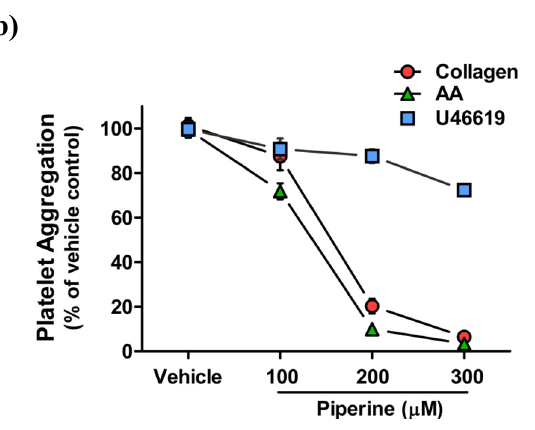
Figure 1. Piperine inhibited the induction of platelet aggregation by collagen and arachidonic acid, but not U46619. ( a ) Chemical structure of piperine; ( b ) Piperine-dependent inhibition of platelet aggregation. Washed platelets (3 × 10 8 platelets/mL) were pre-incubated with piperine for 3 min in the presence of 1 mM CaCl and stimulated with 1 μ g/mL collagen 2 (red circles), 100 μ M AA (blue squares), or 1 μ M U46619 (green triangles) in an aggregometer. The change in light transmission of the platelet suspension following 10 min of stimulation with each agonist was normalized to the light transmission of suspensions treated without piperine (taken as 100%). Each point represents the mean ± S.D. of three separate